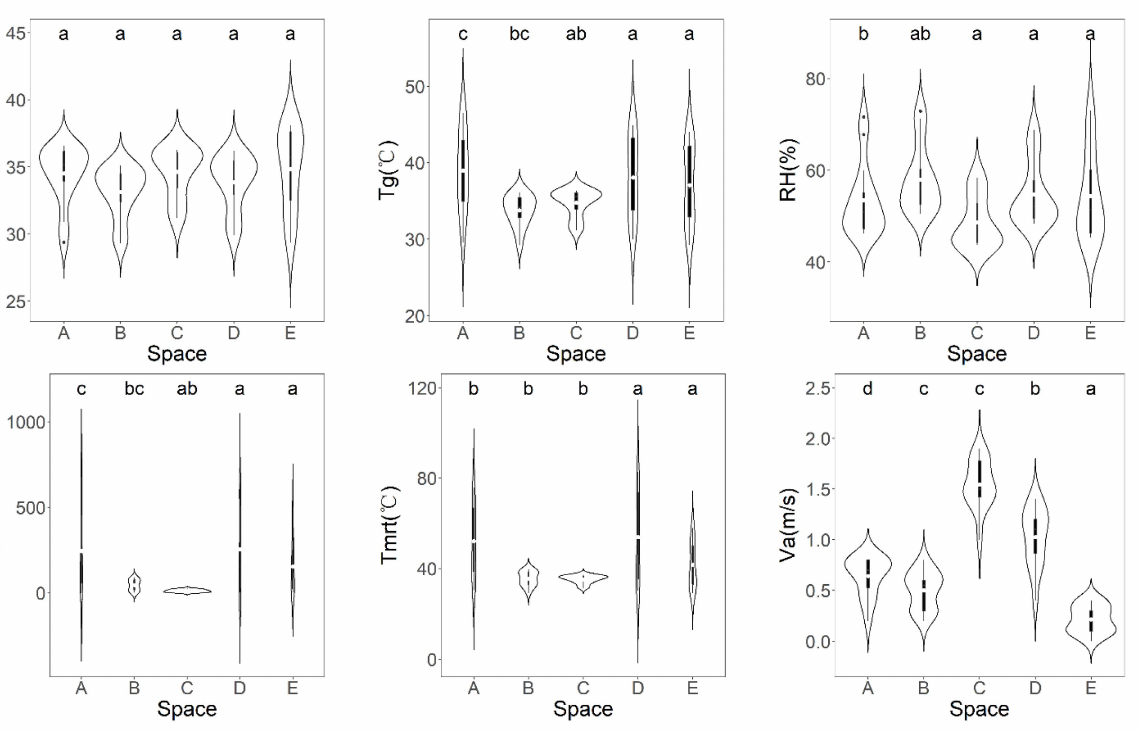
Figure 2. Differences in meteorological parameters by spaces (The capital letters indicate the experi- mental spaces; Different Lowercase letters indicate significant difference ( p ≤ 0.05)).